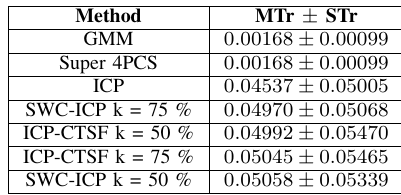
TABLE X: Best seven methods for video ‘freiburg2 rpy’ according to translation average (equation (48)) with standard deviations given by expressions